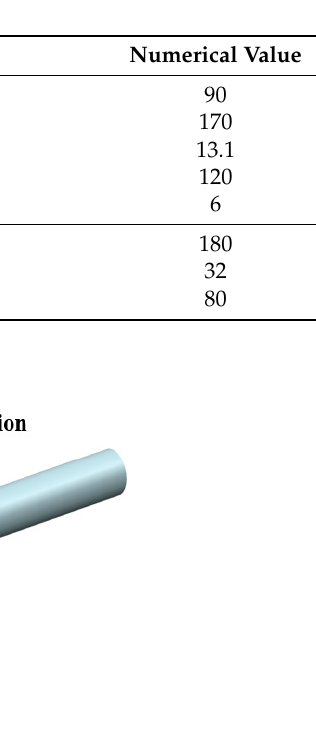
Table 1. Main geometric parameters.